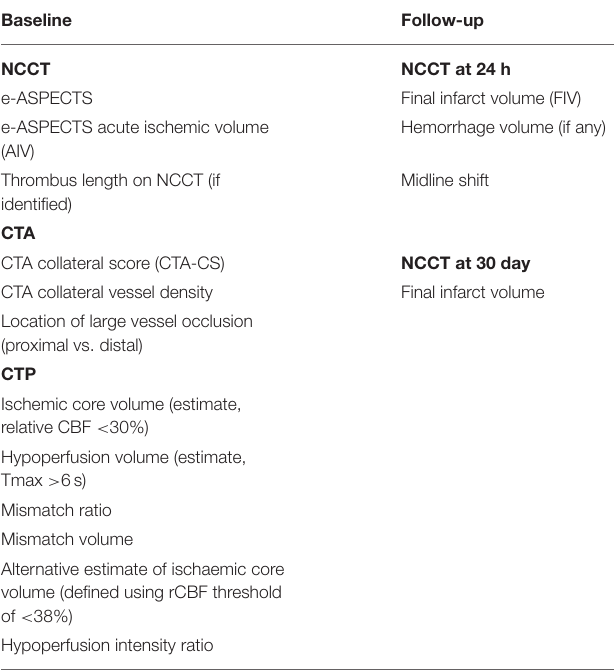
TABLE 1 | Summary of imaging values assessed during the